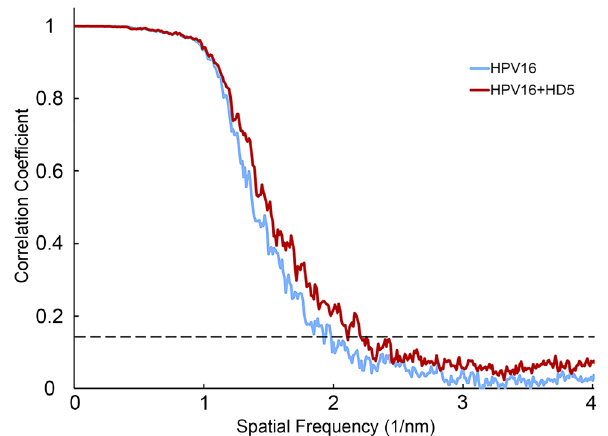
Supplementary Figure 1. Fourier Shell Correlation (FSC) plots for HPV16 and HPV16+HD5 cryo- EM reconstructions. FSC plots calculated by RELION are shown with the HPV16 plot in blue and the HPV16+HD5 plot in red. The resolutions indicated by the 0.143 threshold (dashed line) are 0.53 nm for HPV16 and 0.49 nm for HPV16+HD5.